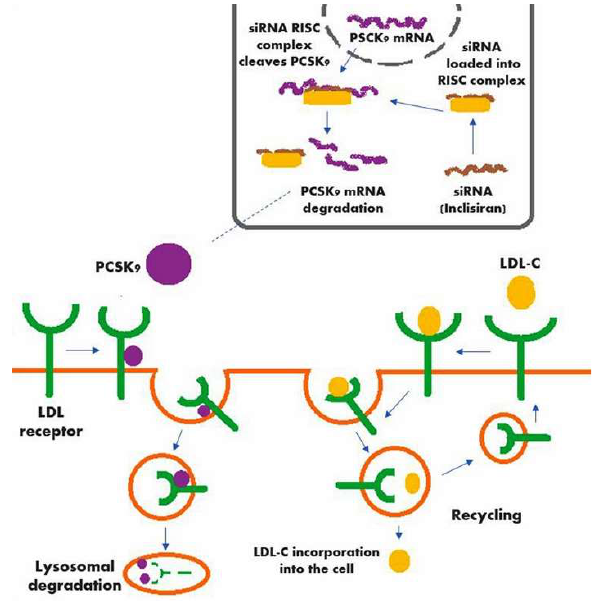
Figure 1. Mechanism of action of inclisiran in conjunction with the action of PCSK9.